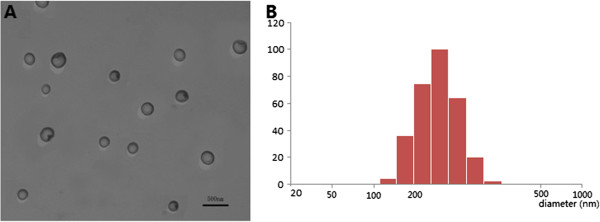
Characterization of nanoparticles. A: morphology revealed by transmission microscopy. B: bar graphs, showing the average diameters detected by NICOMP 380 ZLS.